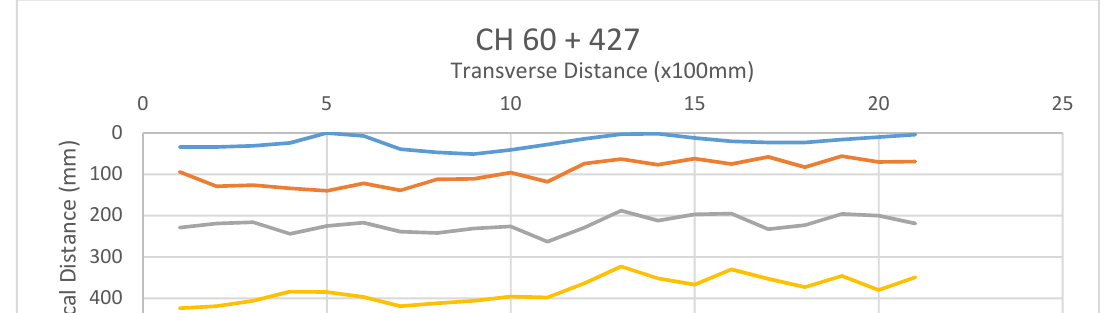
Figure 12. Transverse profile of 60 + 427 km.